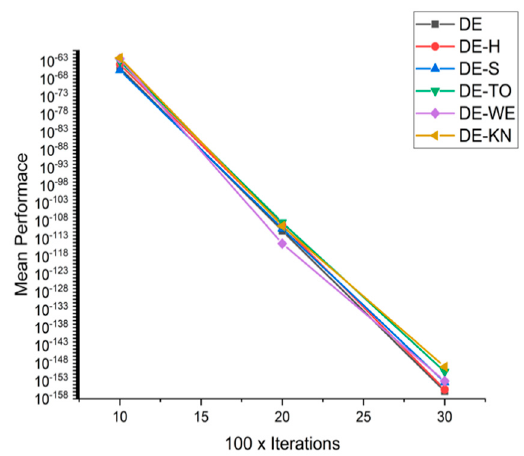
Figure 34. Convergence curve on fn12.